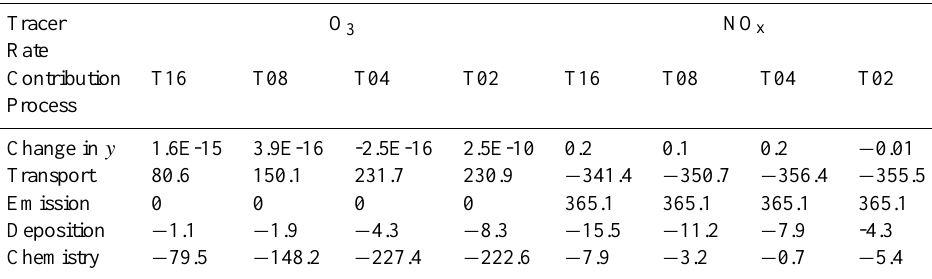
Fig. 4. Time series of (a) O 3 , (b) NO and (c) NO 2 mixing ratios and (d) OH concentration for 24 h of the fifth simulation day. Different exchange rate coefficient cases are shown from left to right: “T16”, “T08”, “T04” and “T02”. Results of the NO DUST simulations and the DUST H simulations are shown in black and red, respectively. Table 5. Changes in O 3 and NO x mixing ratios ( y) during the course of the 5th day of NO DUST simulation, and factors contributing to the budget of each. (unit: nmolmol − 1 )